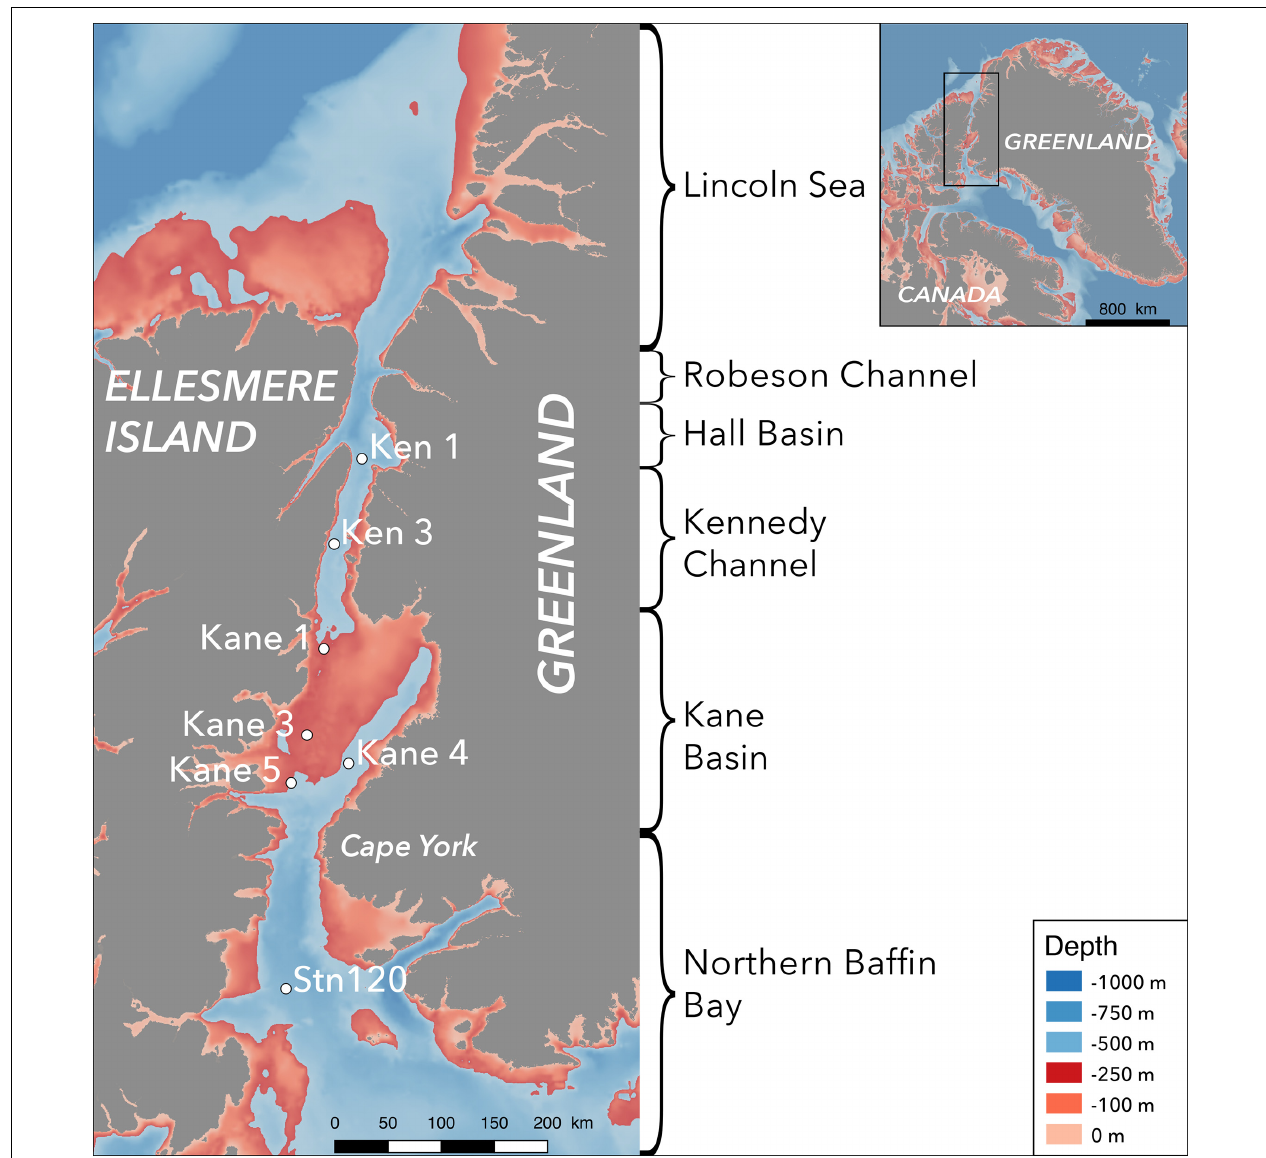
FIGURE 1 | Map of the Nares Strait and top of Baffin Bay, indicating the names of the geographical features and sampling sites. The color scale on the map indicates depth, with shallow depths from 0 and 250 m in reds and deeper waters in blues.